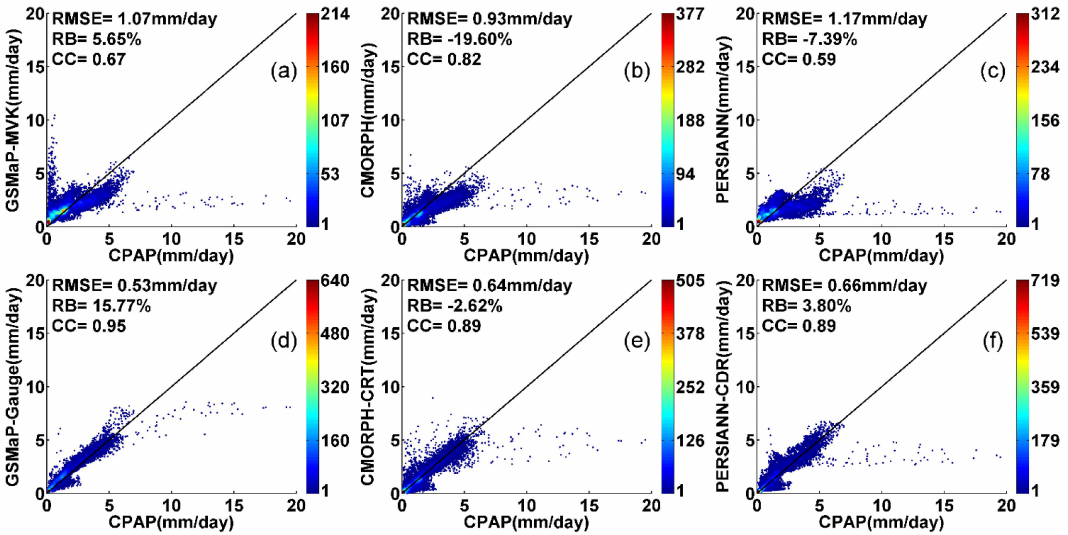
Figure 3. Density-colored scatterplots of various products ( a ) GSMaP_MVK; ( b ) CMORPH; ( c ) PERSIANN; ( d ) GSMaP_Gauge; ( e ) CMORPH_CRT and ( f ) PERSIANN_CDR against CPAP rainfall rate shown in Figure 2. The color represents the occurrence frequency. The dark oblique solid line represents 1:1